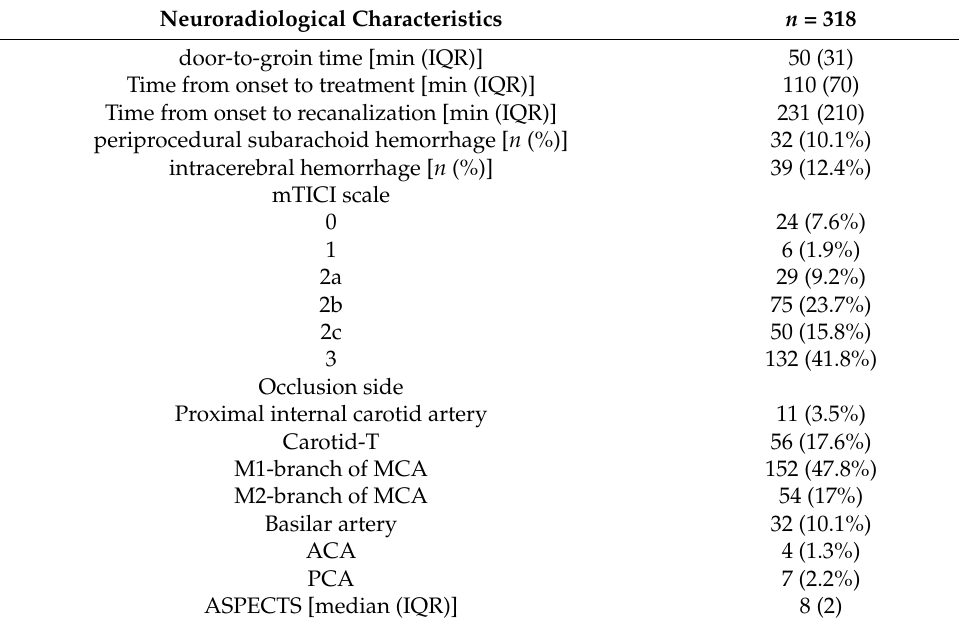
Table 2. Neuroradiological